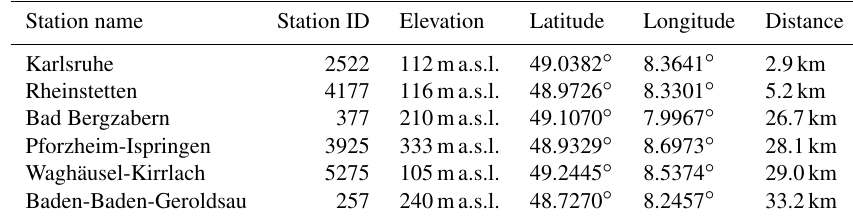
Table 1. Locations of weather stations and distances to the test site. Station